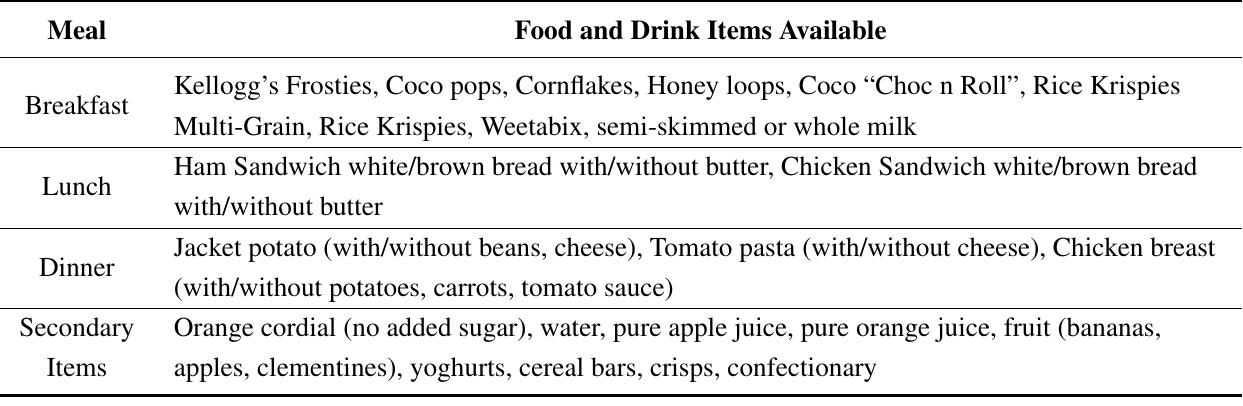
Table 1. Food and drink items made available for the subjects during the study. Meal Food and Drink Items